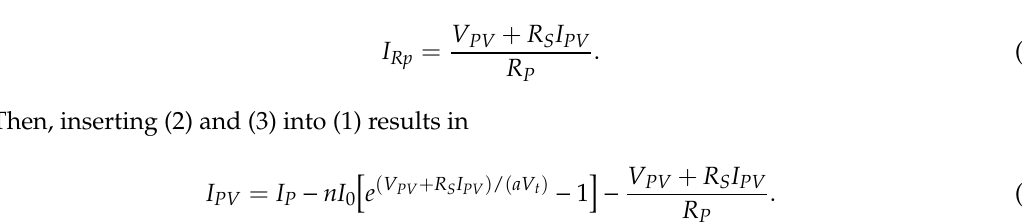
Figure 6. Equivalent circuit of the PV module.